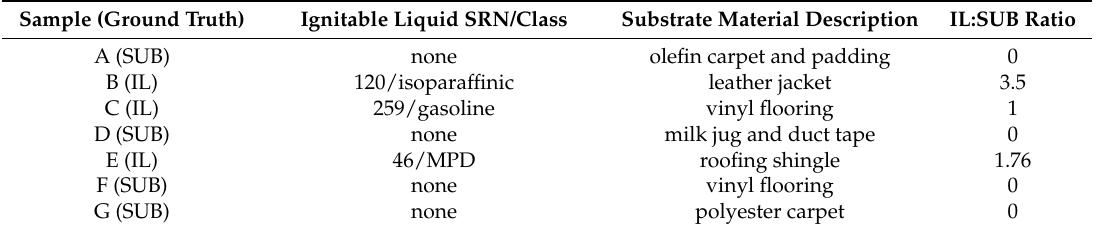
Table 3. Composition on known ground truth simulated casework samples. The IL SRN corresponds to the sample record number in the Ignitable Liquids Reference Collection and Database (ILRC) [11].